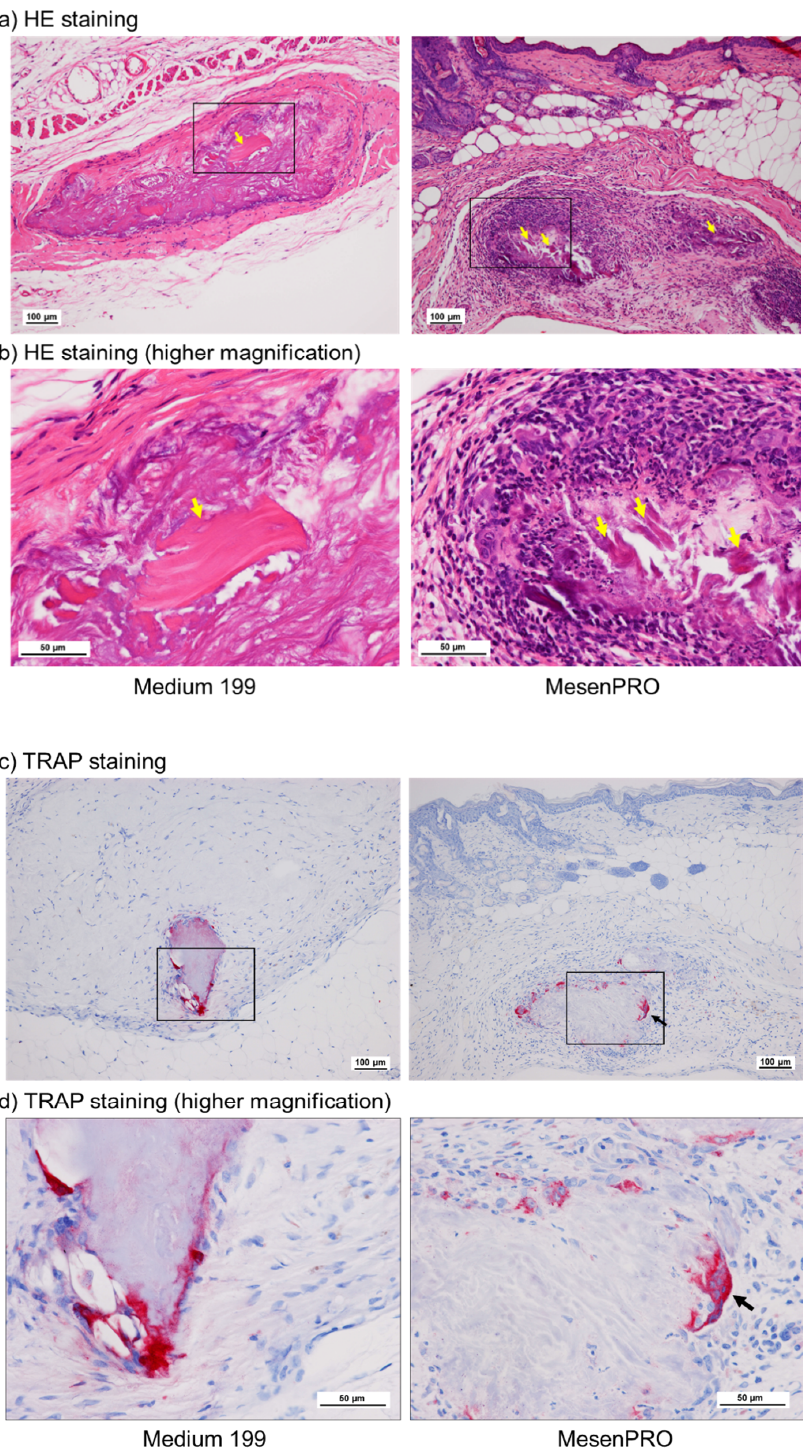
Figure 4. Effects of culture media on new bonelike tissue formation and tartrate-resistant acid phos- phatase+ (TRAP+) cell induction in the implanted TPSs in vivo. ( a,b ) Hematoxylin and eosin (HE) staining and ( c,d ) TRAP staining. Panels ( b,d ) represent higher magnification of the corresponding regions shown in Panels ( a,c ). Yellow arrows represent bonelike tissues. TRAP+ cells were stained red. The black arrow indicates representative TRAP+ multinucleated cells